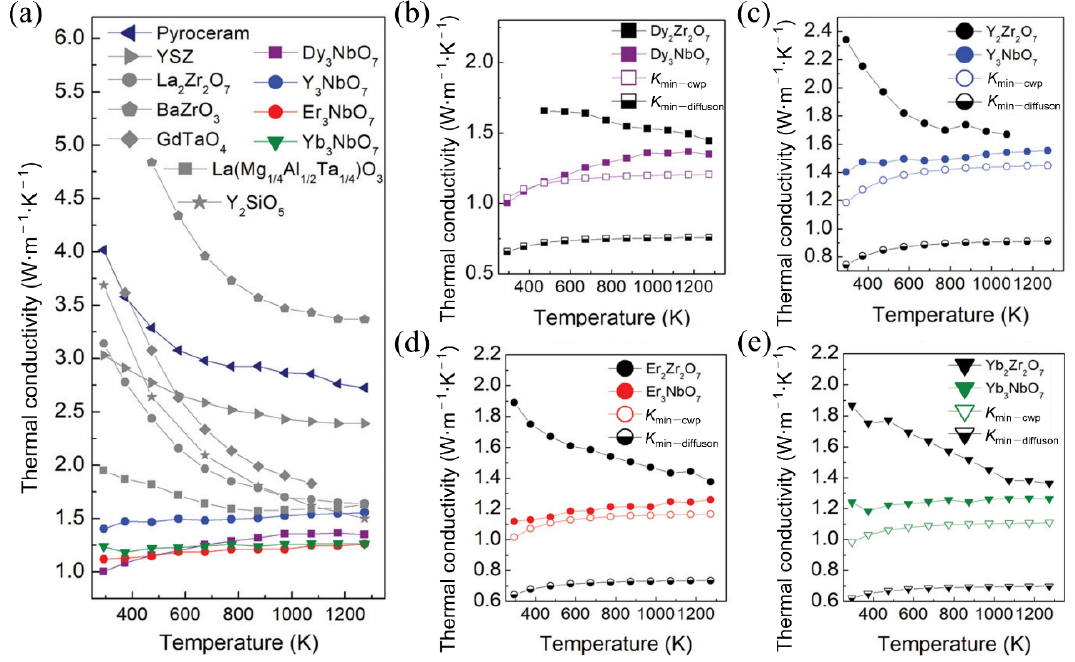
Fig. 8 Thermal properties of RE 3 NbO 7 (RE = Dy, Y, Er, Yb). (a) Thermal conductivities of RE 3 NbO 7 compared to other new ceramic TBC materials and conventional 7YSZ; (b–e) thermal conductivities of RE 3 NbO 7 and RE 2 Zr 2 O 7 and the minimum thermal conductivity calculated by the CWP model and diffusion model. Reproduced with permission from Ref. [72], © WILEY-VCH Verlag GmbH & Co. KGaA, Weinheim